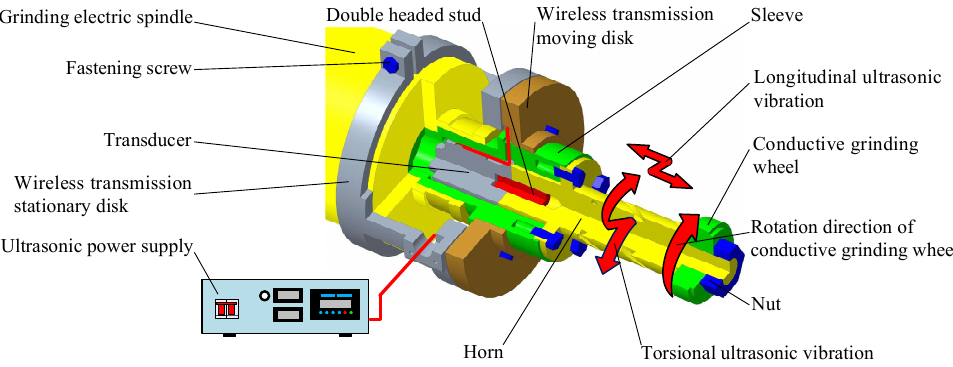
Figure 5. Schematic diagram of the ultrasonic vibration system.